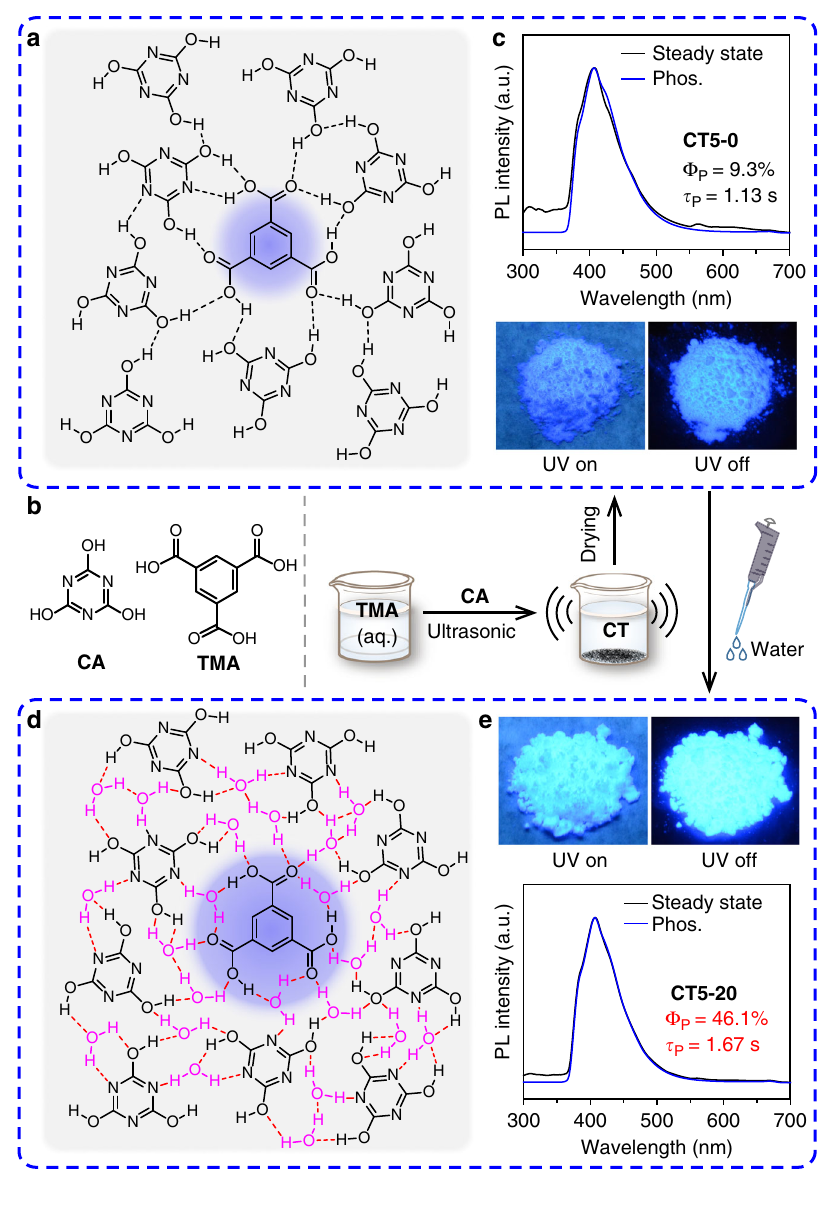
Fig. 1 Preparation of highly ef fi cient deep-blue OURTP materials. a , d Molecular interactions between CA and TMA before ( a ) and after ( d ) the water implement. b Molecular structures of CA and TMA, and preparing procedures of their composites (CT). c , e Steady state and phosphorescent (phos.) spectra and photographs under (UV on) or after (UV off) 254 nm irradiation of CT5-0 ( c ) and CT5-20 ( e